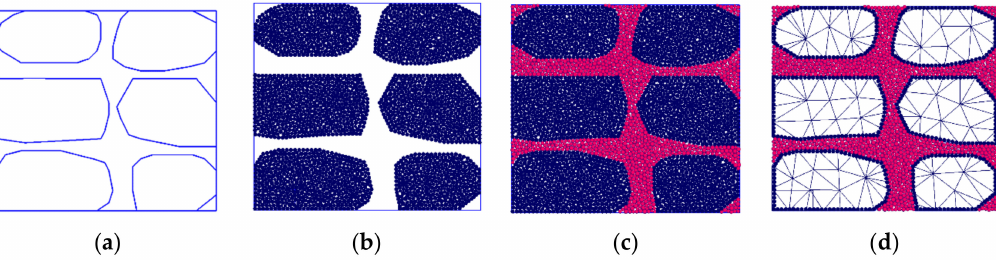
Figure 3. Bilinear softening contact model: ( a ) normal direction; ( b ) shear direction [13,26].